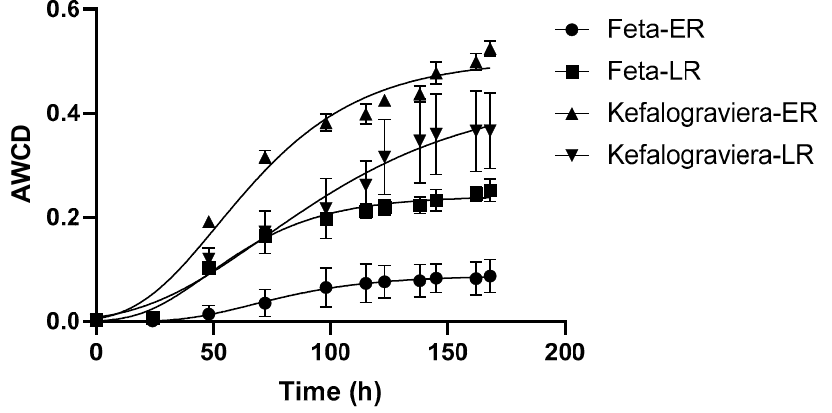
Figure 5. Average Well Color Development of the Biolog EcoPlate incubated at 30 °C for 168 h, reflecting the metabolic activity of the microbial community of Feta and Kefalograviera cheese samples during their ripening. ER, early ripening; LR, late ripening; sigmoidal solid line, predicted values drawn by fitting the Gompertz equation to the observed values with non-linear regression; solid symbols, observed data expressed as mean values of six replicates (three technical × two biological) along with error bars (standard deviation).